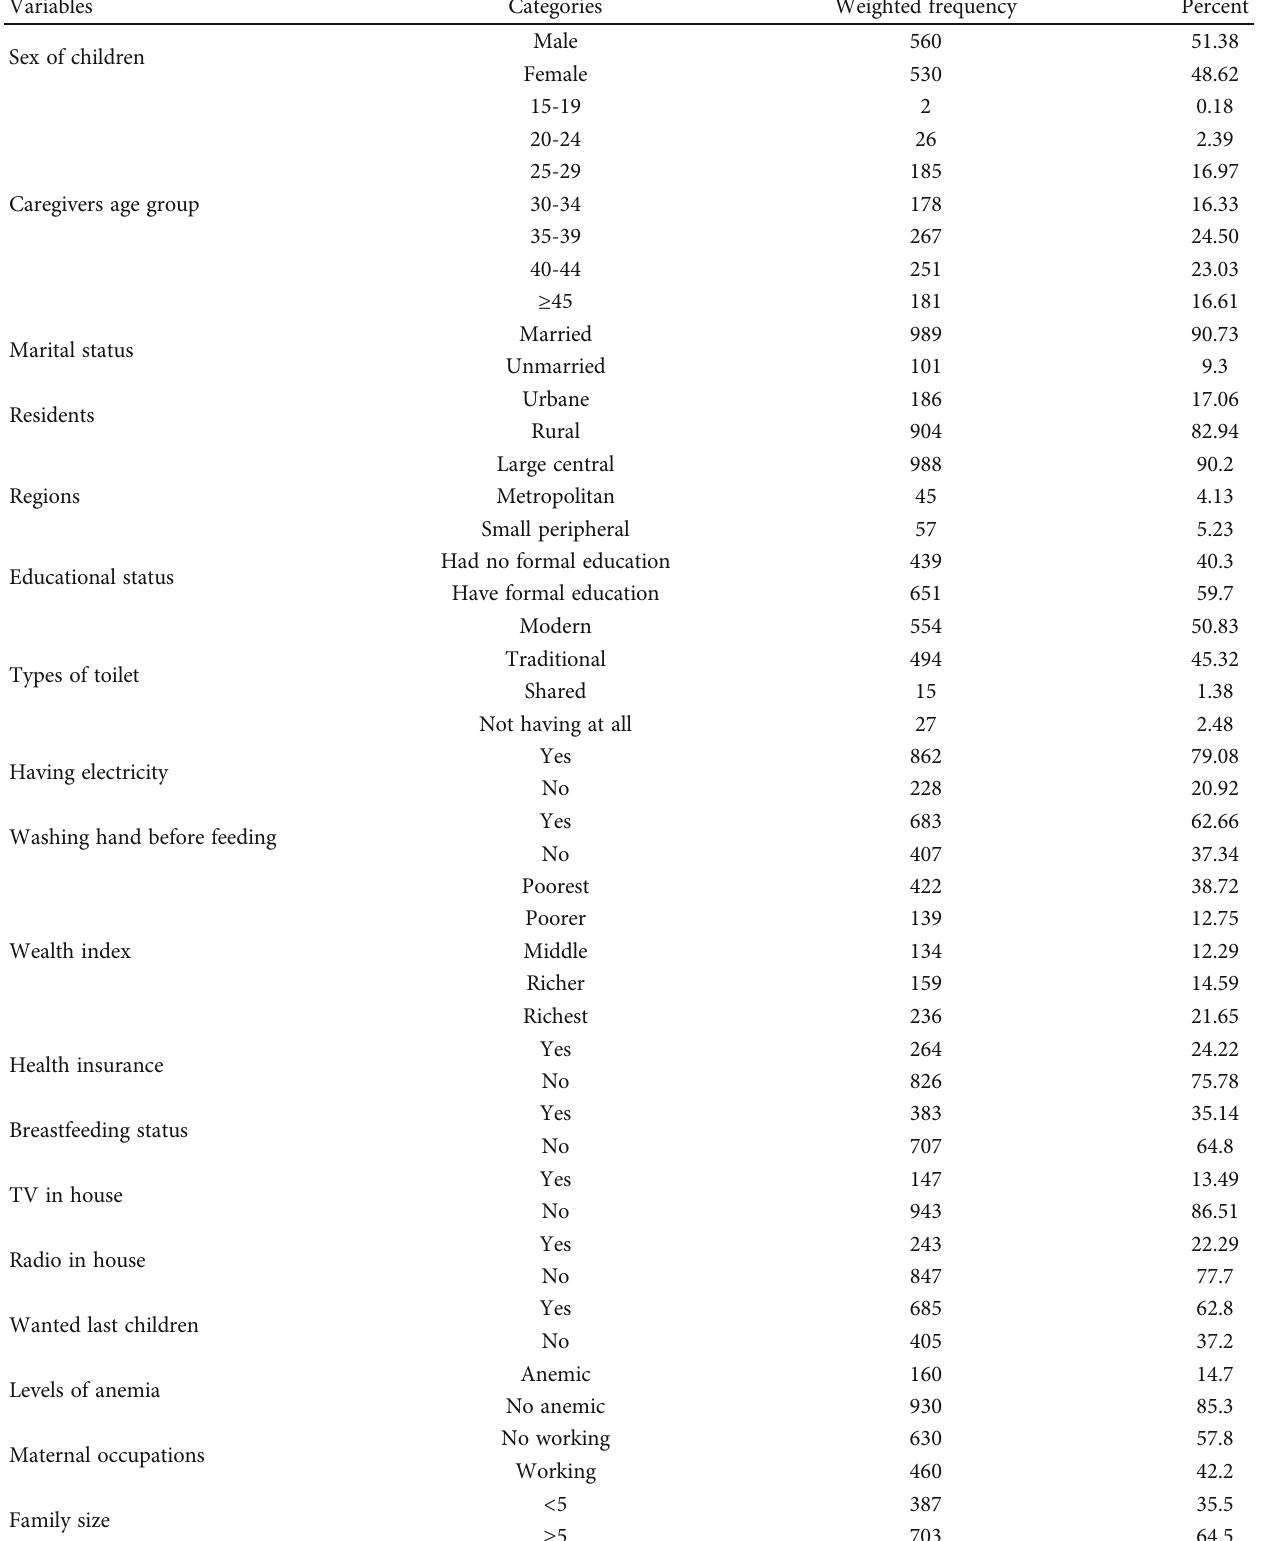
Table 1: Baseline sociodemographic and clinical characteristics of the study